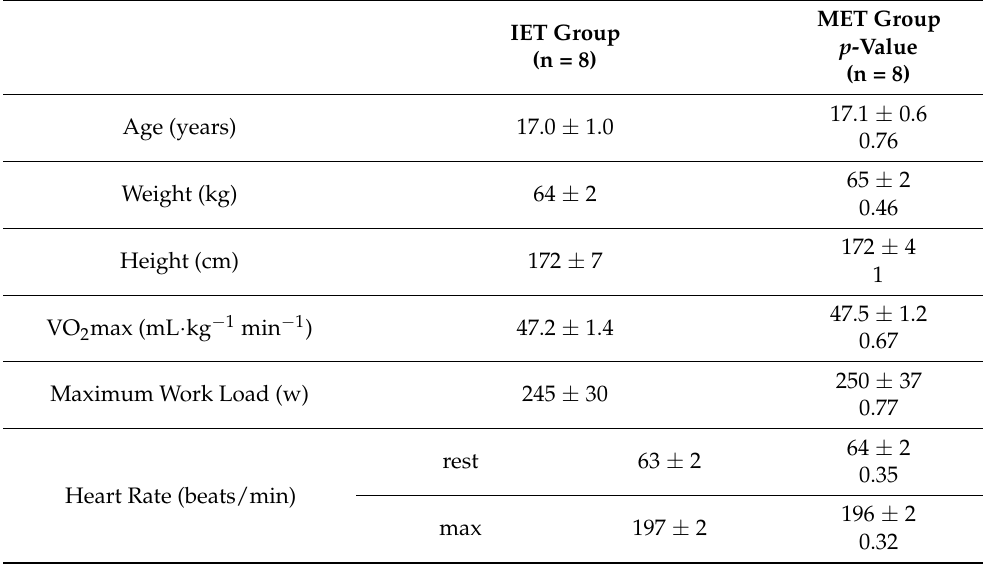
Table 1. Subject characteristics and maximal exercise performances of athletes at the start of the study (T1). Data are mean ± standard deviation (SD). IET group: intense endurance training group; MET: moderate endurance training